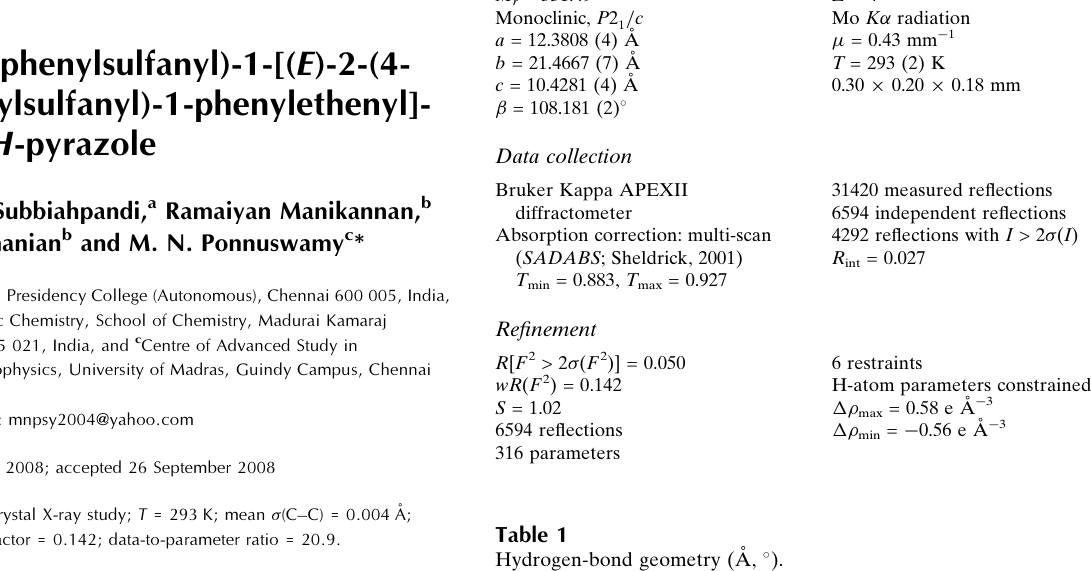
Hydrogen-bond geometry (A˚ , (cid:1)